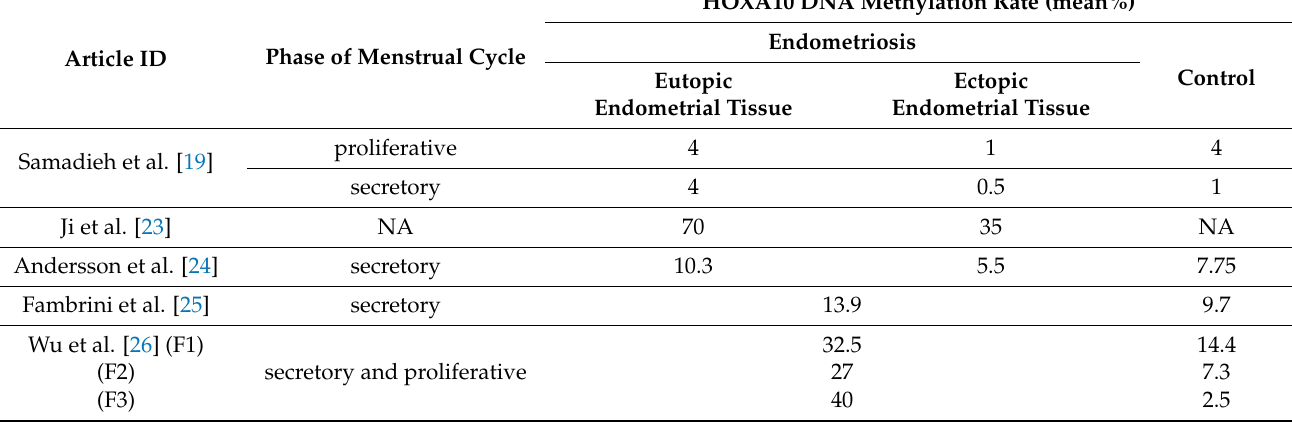
Table 2. Comparison of HOXA10 DNA methylation level between control and endometriosis patients that is divided into types of endometrial tissue